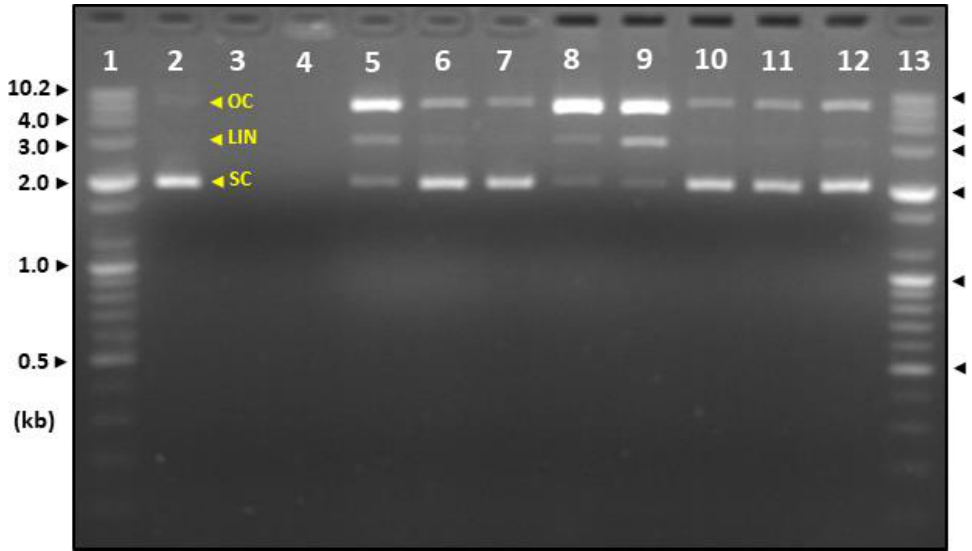
Figure 7. Comparisons of agarose gel electrophoresis for DNA protective effects of 50% MeOH extracts from household and commercial doenjang . Lane 1 and 13, size mark; lane 2, untreated; lane 3, blank; lane 4, treated; lane 5–8, 1HDJ–4HDJ; and lane 9–12, 1CDJ–4CDJ. OC, open circular; LIN, linear; and SC, supercoiled.